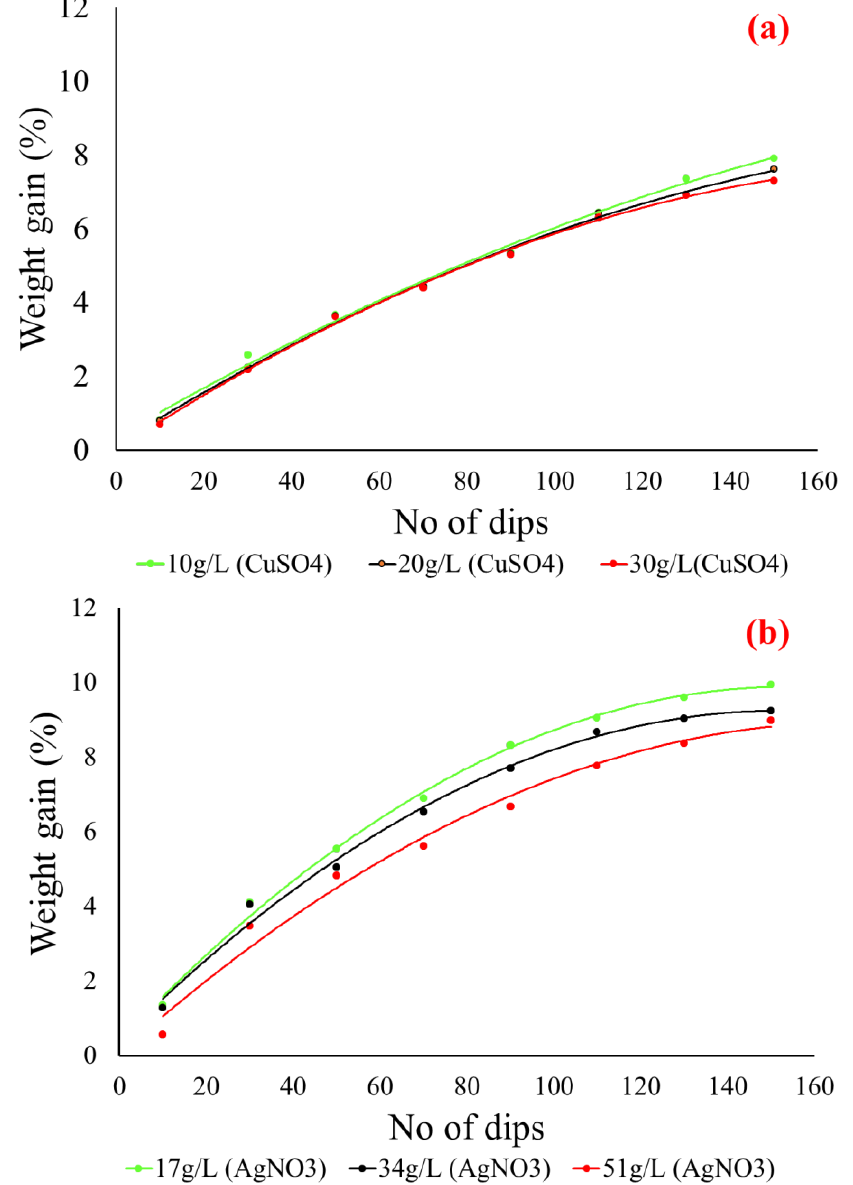
Figure 8 . The weight gain percentage with increase in number of dipping cycles ( a ) Cu-NPs coated cotton fabric, ( b ) Ag-NPs coated cotton fabric .